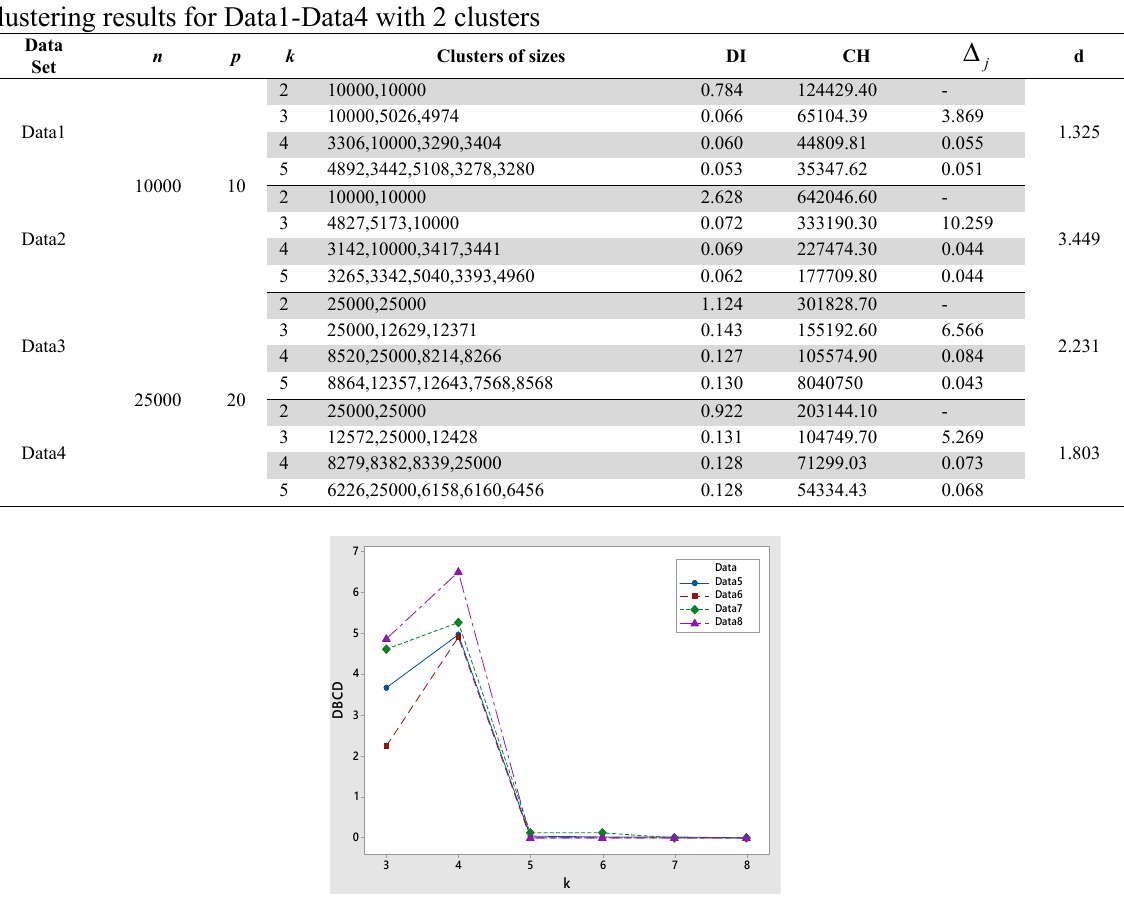
Fig. 5. Scatter plot for distance between cluster centroids (DBCD) vs k for